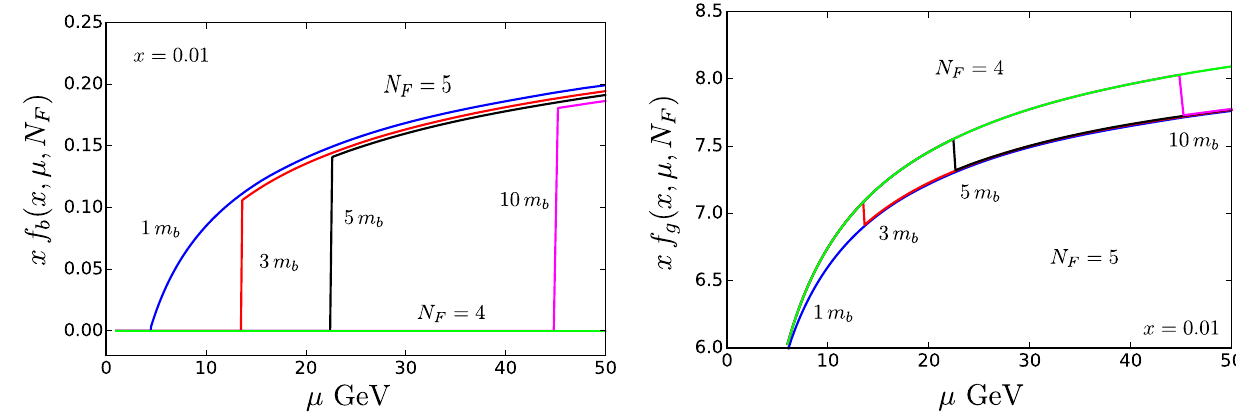
Fig. 12 N F -dependent PDFs x f i ( x ,μ, N F ) for the bottom quark as a function of μ in GeV. The vertical lines in the plots show the (left) and gluon (right) with variable matching scales for μ b = transition from the N F = 4 to N F = 5 flavor { 1 , 3 , 5 , 10 , ∞}× m = 0 . 01 b {blue, red, black, magenta, green} with x